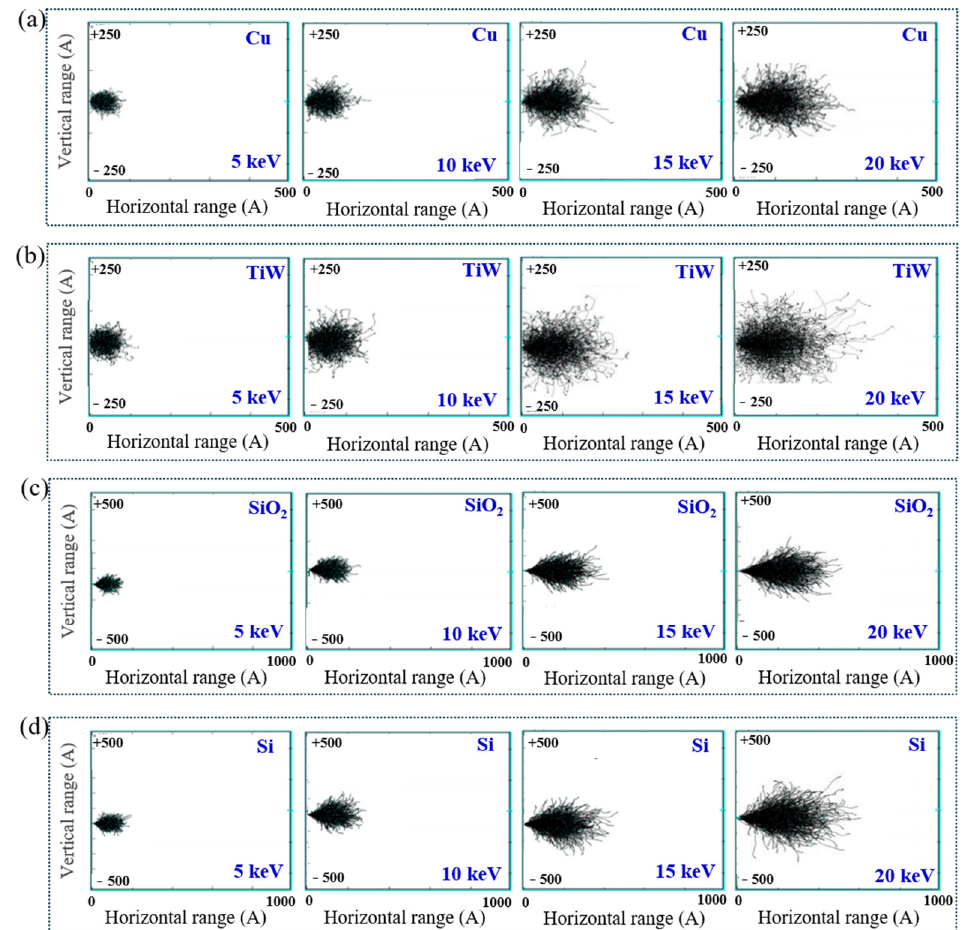
Figure 15. Incidence trajectories of Ga + in various materials with different energies: ( a ) Cu; ( b ) TiW; ( c ) SiO 2 ; ( d ) Si.